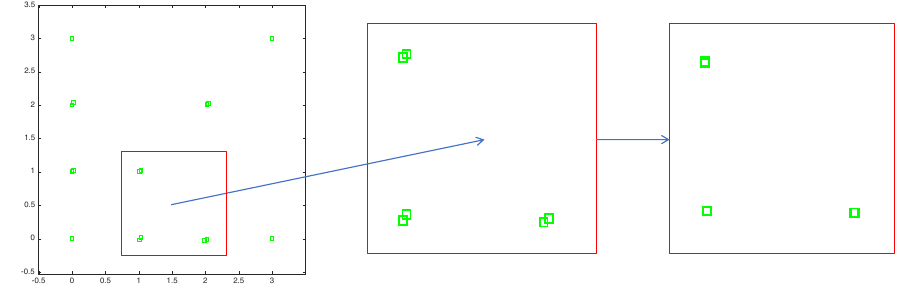
Figure 10. Base point estimation errors and fine-tuned results. Green squares on the left are the estimated base points. Several points should have been identically overlapped but are slightly dispersed (enlarged in the center). After vanishing point refinement, the divergences are reduced substantially (right